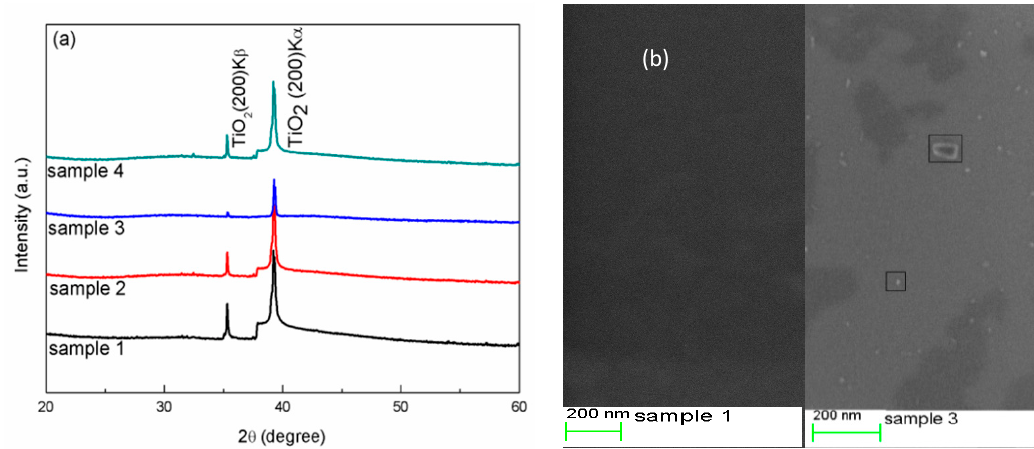
Figure 1. ( a ) XRD spectra of samples 1–4 prepared by magnetron sputtering. ( b ) The top view of SEM microphotograph of sample 1 ( left ) and sample 3 ( right ).